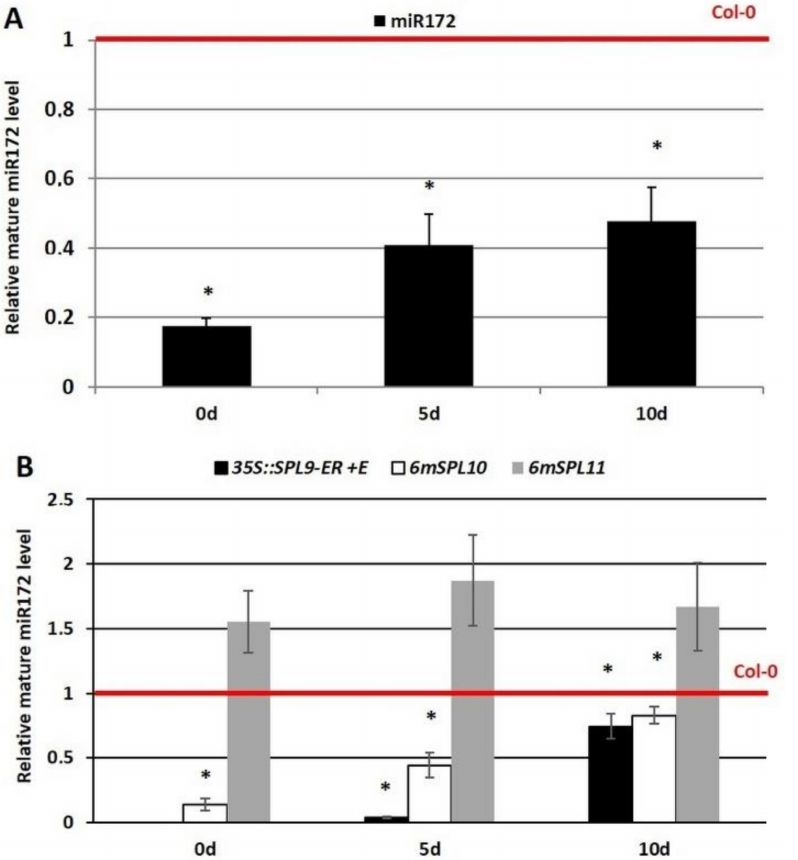
Figure 8. Level of mature miR172 in the embryogenic culture of 35S::MIM156 with a disrupted miR156 function ( A ) and an SPL9 -overexpression line (35S:: SPL9 -ER) and the 6mSPL10 and 6mSPL11 mutants with a disrupted miR156-binding site ( B ). SPL9 overexpression was induced with β -estradiol (+E). The relative miRNA level was normalized to an internal control ( At4g27090 ) and calibrated to the WT (Col-0) culture of the same age (0 d, 5 d, and 10 d). *—value significantly different from the Col-0 culture of the same age ( p < 0.05; n = 3 ± SD).